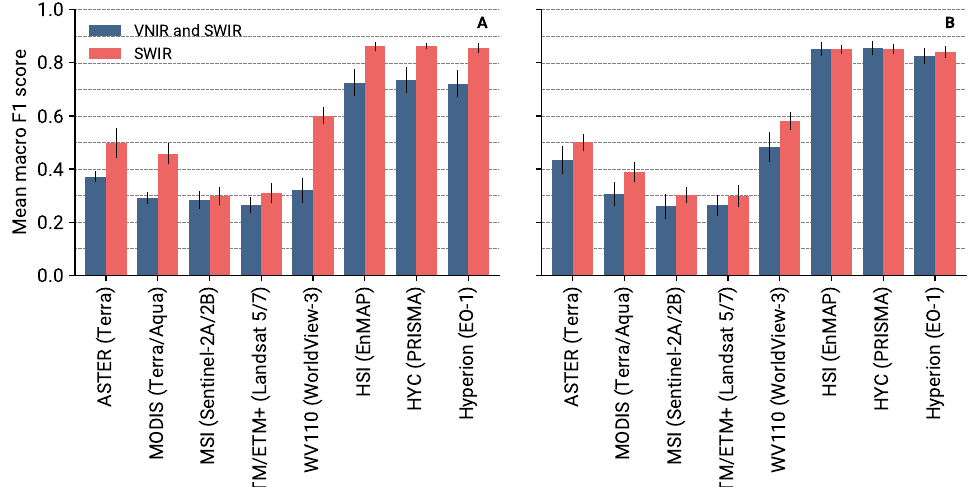
Figure 13. Mean macro F1 scores obtained with ( A ) k-NN and ( B ) RF for multispectral VNIR/SWIR and hyperspectral sensors while signals of VNIR and SWIR channels or of only SWIR channels were considered,